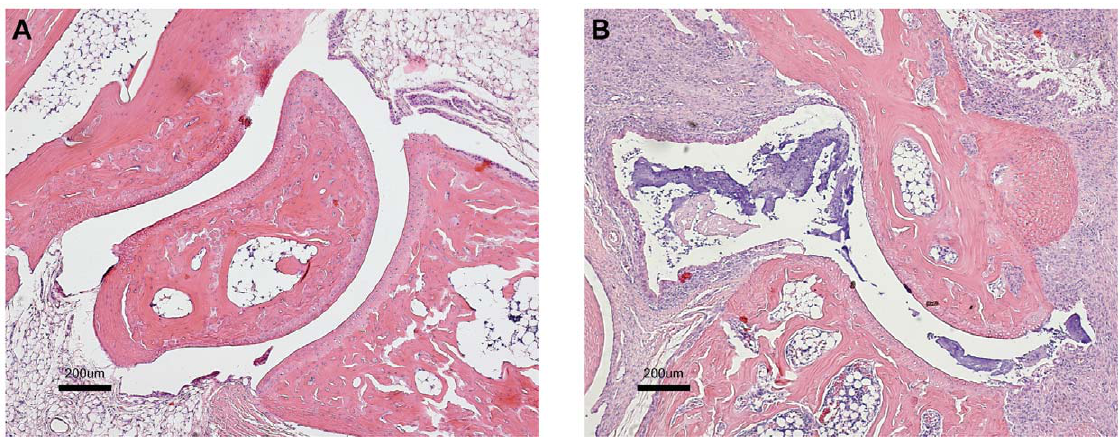
Figure 3. Histology of paw joints from BSSL-KO and BSSL-WT mice. Hematoxylin and eosin staining of hind limb sections from (A) BSSL-KO and (B) BSSL-WT mice taken at day 57 after initial injection with rat CII. The joint of BSSL-KO mice has normal histological appearance without cellular infiltration whereas the joint of BSSL-WT mice shows signs of cartilage destruction and significant inflammatory cell infiltration. Images shown are representative of those obtained from five mice in each group. Original magnification 6 4.